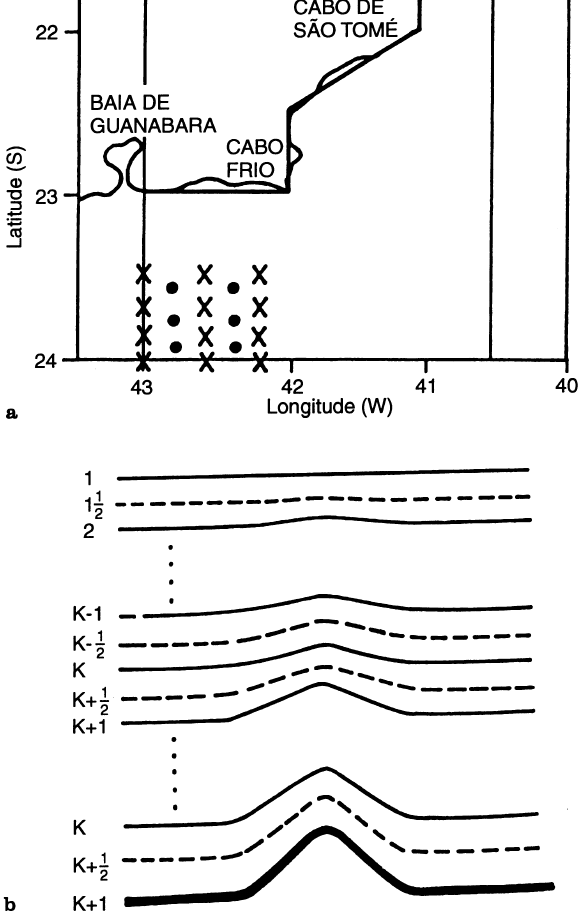
Fig. 4a,b. Structure of the model grid: a horizontal: the horizontal velocity components are defined at the cross-points, and all the other variables are defined at the dot points; b vertical: the vertical velocity is defined at the levels of the model ( solid lines ), and all the other variables are defined at the intermediate levels ( broken